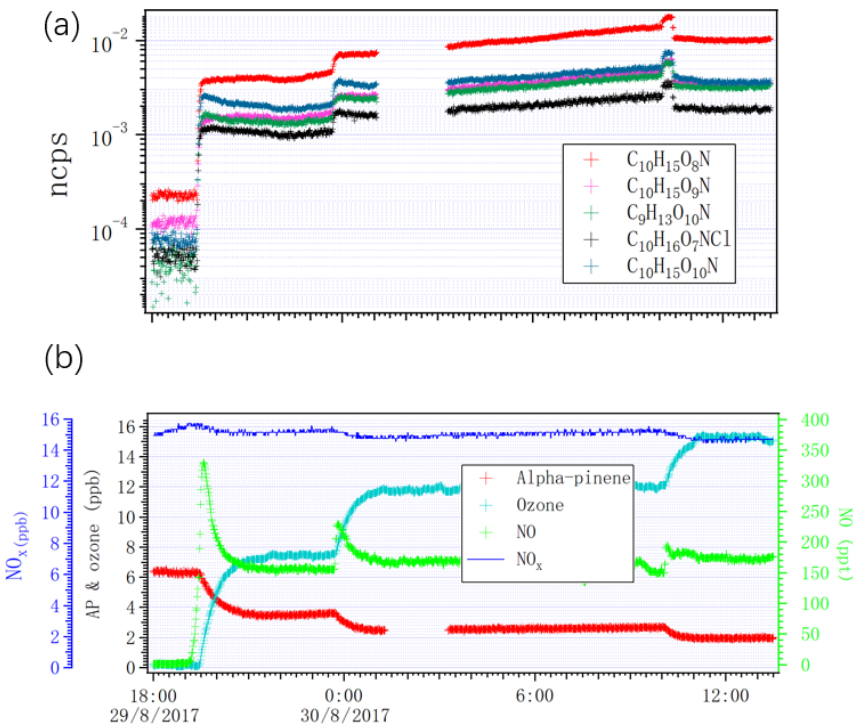
Figure 9. Time series of (a) selected HOMs measured by NO 3 CI-APi-ToF and (b) NO x , alpha-pinene, ozone and NO as the lights switched on from zero to two, four and seven.